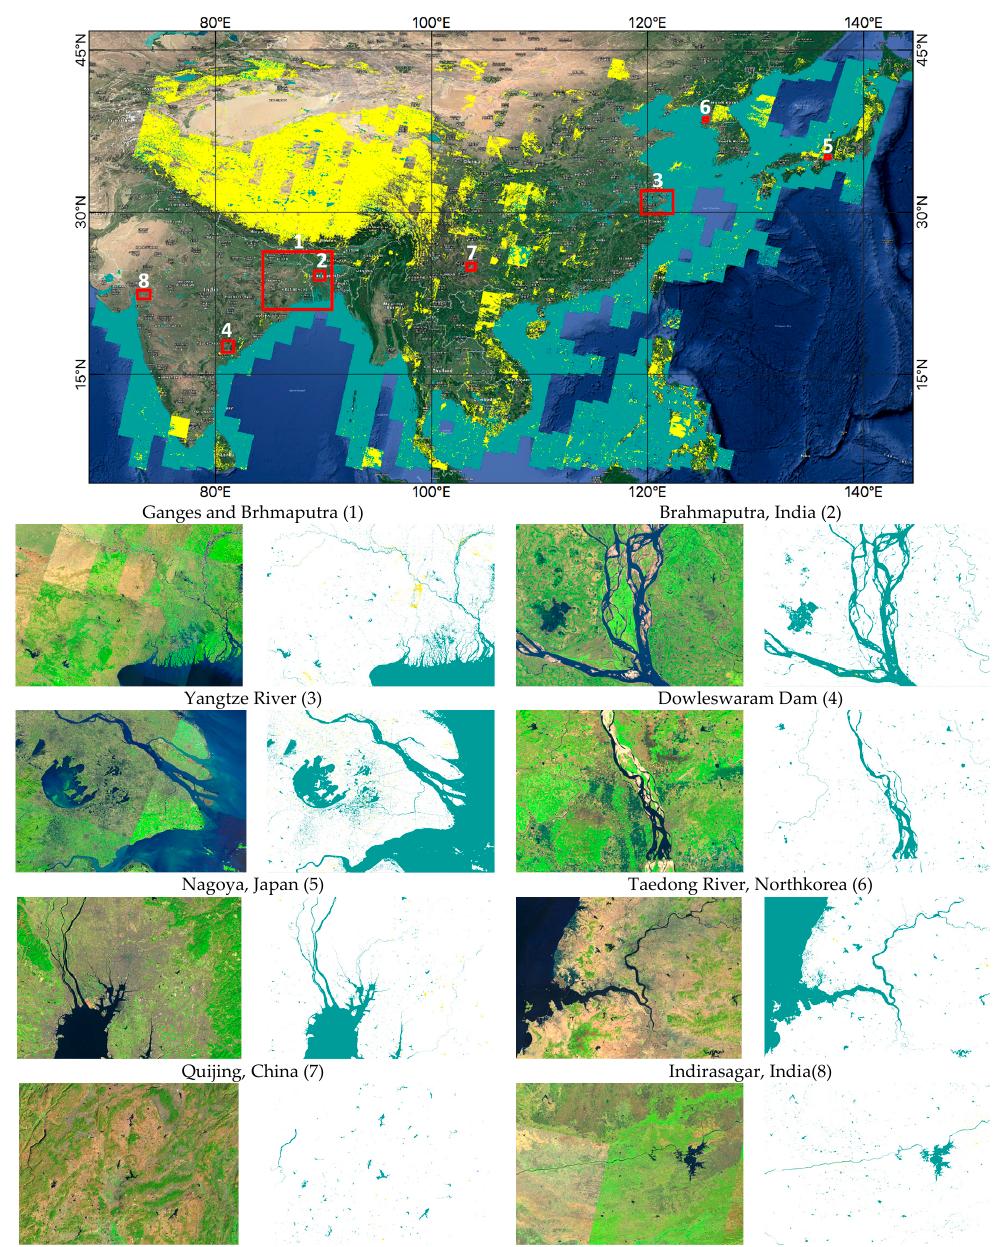
Figure 8. Demonstration of water region estimation using 900 Landsat-8 images over East Asia and India (green: water; yellow: cloud).